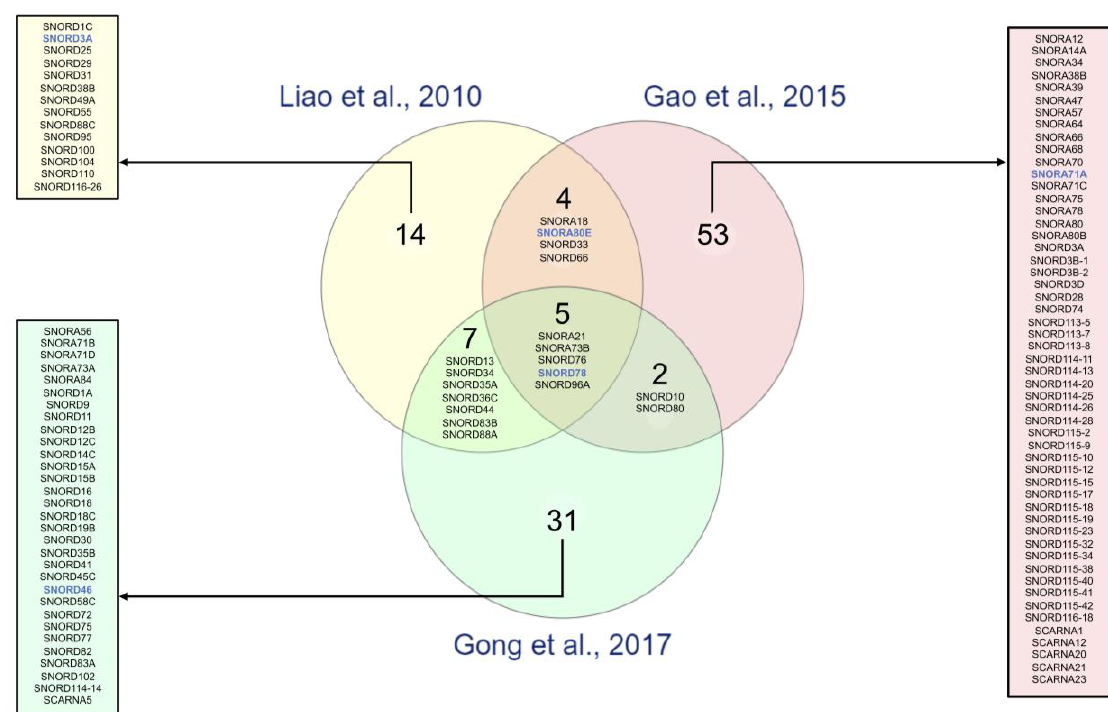
Figure 1. Comparison of snoRNA signatures in primary lung cancer tissues. Three studies identified snoRNAs significantly dysregulated in lung cancer using pairs of cancerous and non-cancerous primary pulmonary tissues at diagnosis using di ff erent approaches (yellow, Liao et al., 2010 [48]: microarray; red, Gao et al., 2015 [49]: RNA-seq; and green, Gong et al., 2017 [3]: analysis of public TCGA dataset). The Venn diagram presents the logical relation between the datasets of significantly altered snoRNAs provided by these three studies. Briefly, we uploaded the snoRNA lists provided by each study and identified snoRNAs present either in 1, 2 or 3 datasets using an online visualization tool (http: // www.molbiotools.com / listcompare.html). Intersections correspond to snoRNAs